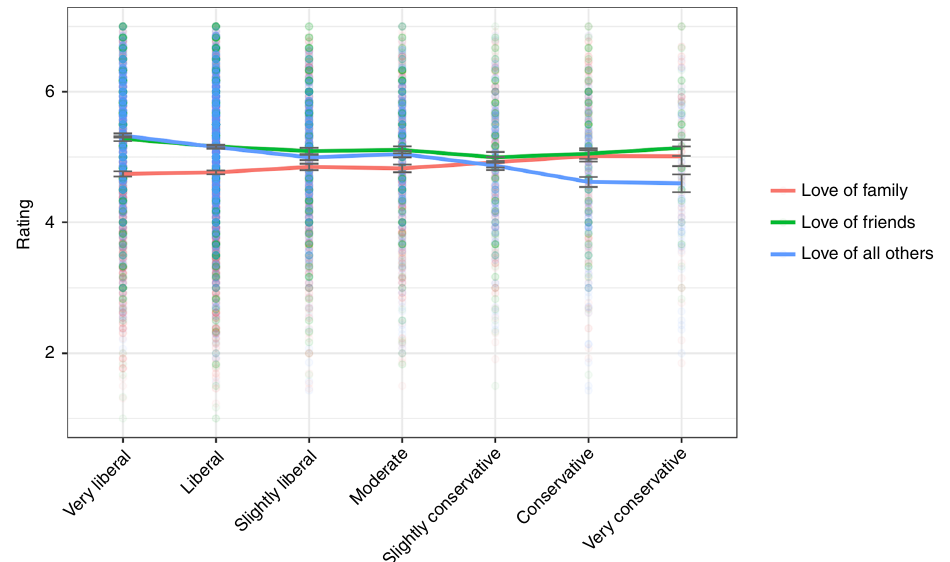
Fig. 1 Love by political ideology, Study 1a. Error bars represent standard errors, solid lines indicate means. Source data are provided as a Source Data fi